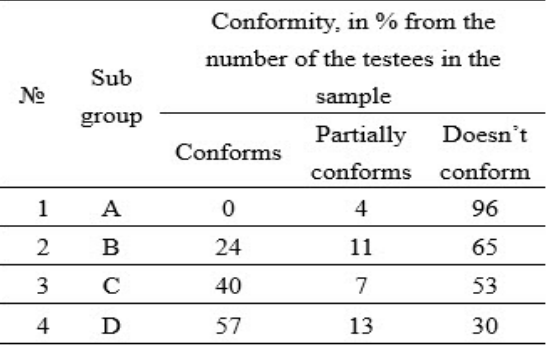
Table 2. Analysis of conformity of the career image to the